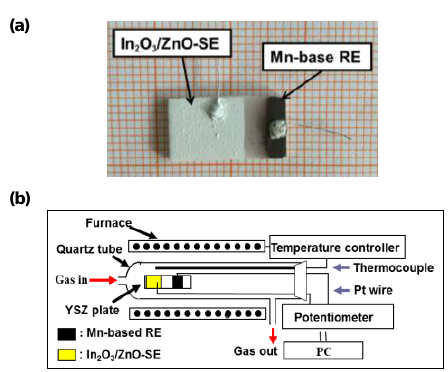
Figure 1. ( a ) Photograph of the fabricated sensor comprised of In 2 O 3 /ZnO composite SE and Mn-based RE; ( b ) schematic view of the gas sensing characteristics evaluation apparatus.